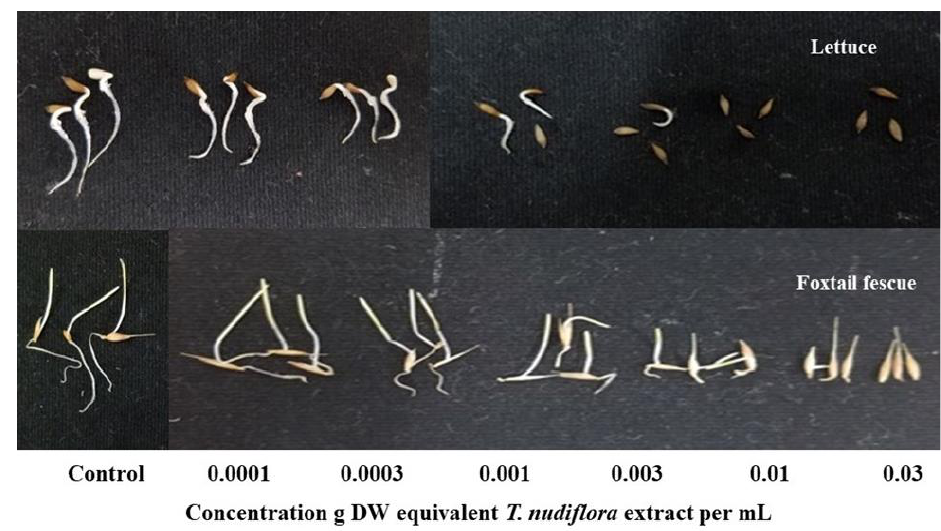
Figure 2. The effect of treatments at six concentrations (control, 0.0001, 0.0003, 0.001, 0.003, 0.01, and 0.03 g DW equivalent T. nudiflora extract mL − 1 ) on the growth of lettuce and foxtail fescue.